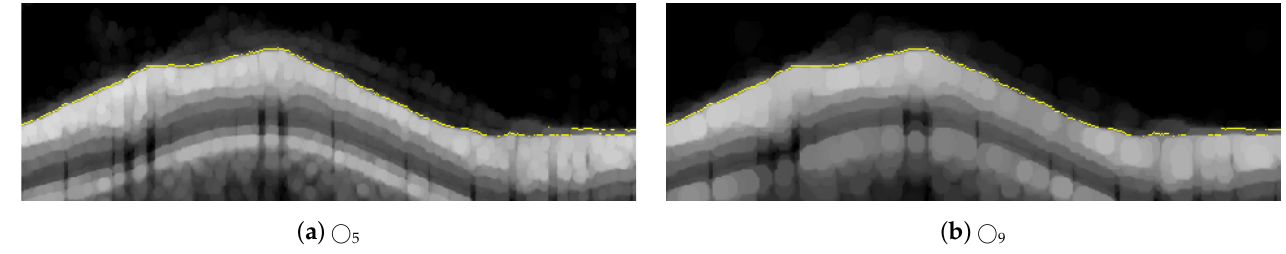
Figure 16. Results of changing the radius of the structuring element from (cid:13) 7 to (cid:13) 5 and (cid:13) 9 , used in the steps illustrated in Figure 7b–d for the delineation of #1-UB.